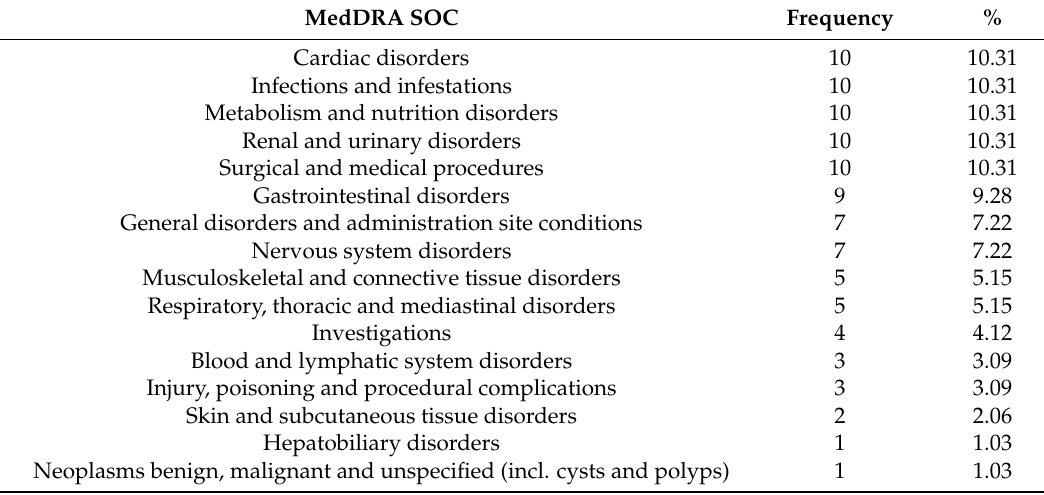
Table 17. Overview of AEs occurring in predialysis patients.